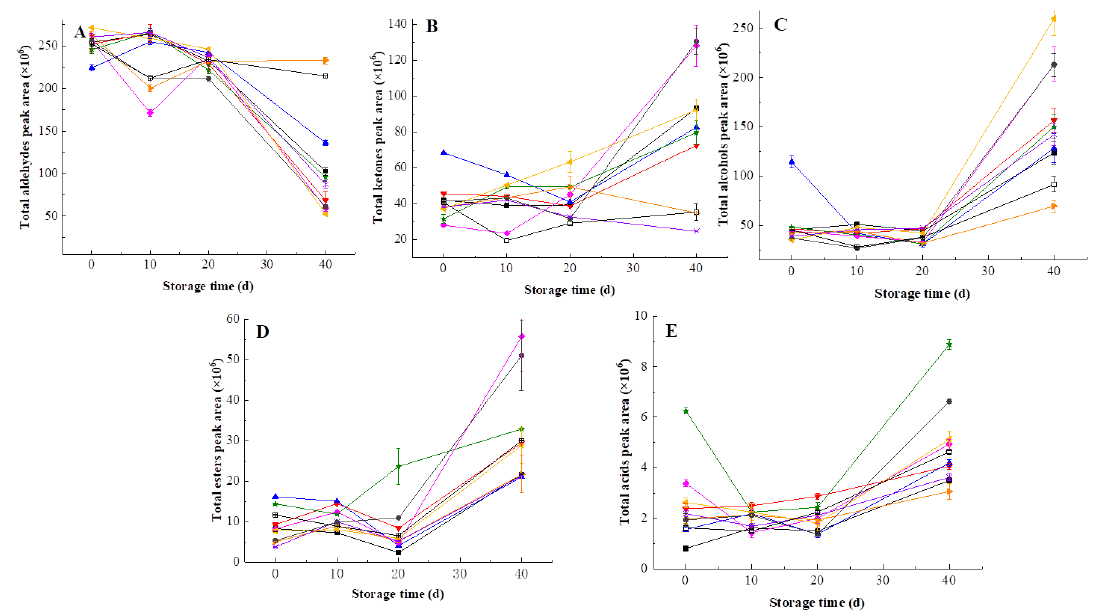
Figure 8. Changes of volatile groups in heat-treated and HHP-treated kiwifruit pulp beverage during storage at 4 °C for 40 days. ( A ) Total aldehydes content; ( B ) total ketones content; ( C ) total alcohols content; ( D ) total esters content; ( E ) total acids content. Heat treatment (85 °C for 10 min) ( ■ ), HHP (high hydrostatic pressure, 400–600 MPa for 5–15 min): 400 MPa/5 min ( ▼ ), 400 MPa/10 min ( ▲ ), 400 MPa/15 min ( ★ ), 500 MPa/5 min ( ◆ ), 500 MPa/10 min ( ◀ ), 500 MPa/15 min ( ▶ ), 600 MPa/5 min ( × ), 600 MPa/10 min ( ● ), 600 MPa/15 min ( □ ). All data were expressed as means ±SD, n = 3.